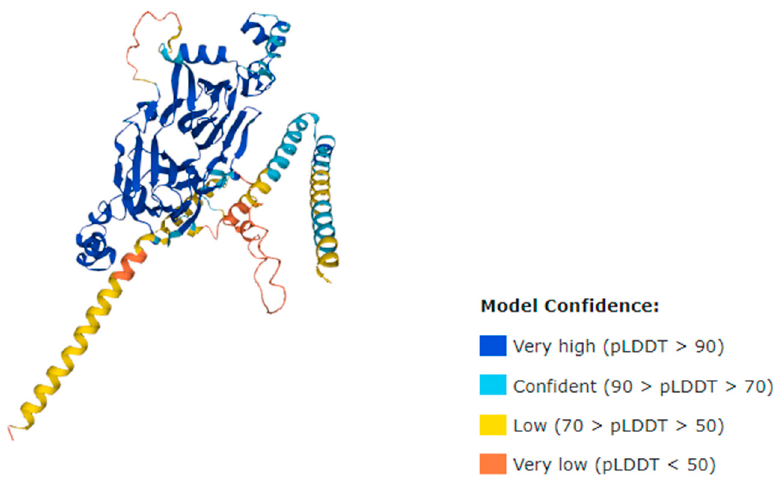
Figure 7. Globulin structure in the rice bran product developed based on structure modelling.